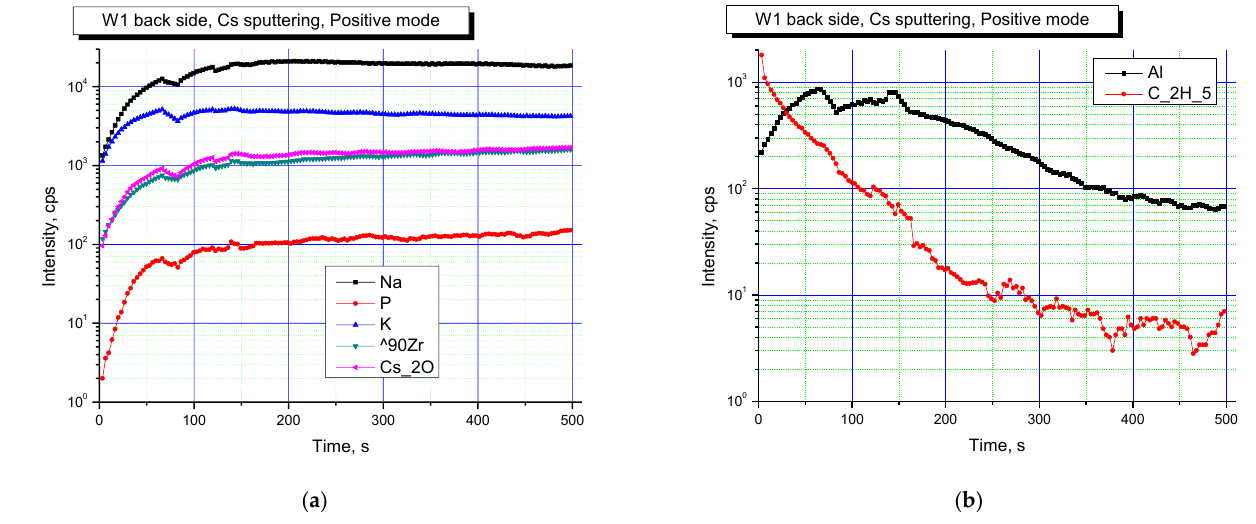
Figure 7. Profiles of main ( a ) and doping ( b ) elements on the surface of the Na 0.5 Zr 2 (PO 4 ) 2.5 (WO 4 ) 0.5 ceramics in the initial state. Positive secondary ion detection mode. SIMS.